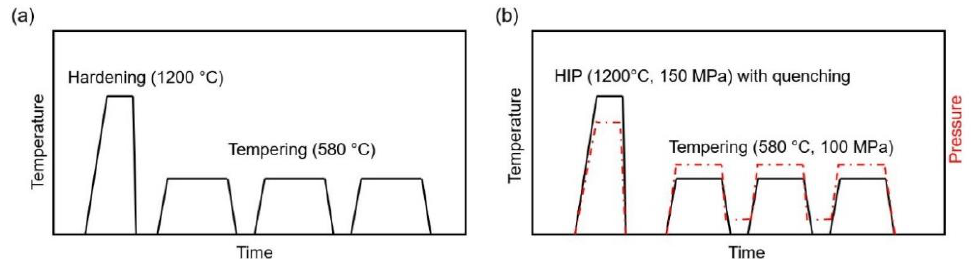
Figure 2. Schematic diagram of post treatments: ( a ) conventional heat treatment; ( b ) hot isostatic pressing (HIP) integrated with quenching and tempering.